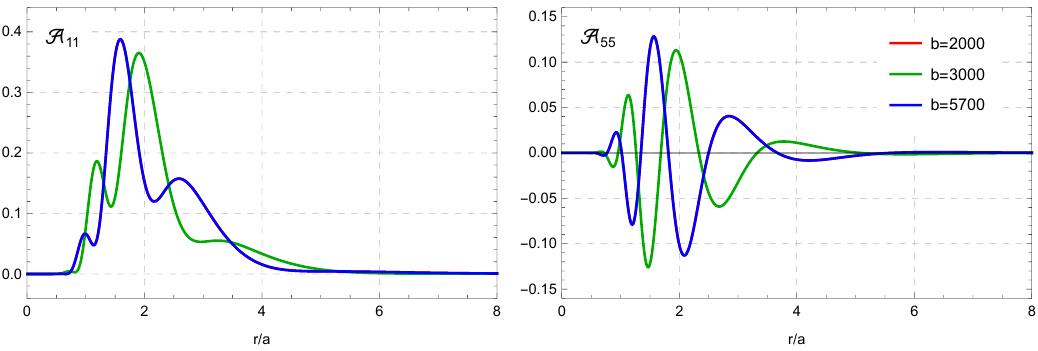
Figure 5 . Graphs of A 11 and A 55 for n = 9 and ˜ b = 2000 , 3000 and 5700. The curves are rescaled √ by ˜ b 2 ≡ ( b/ 2 a ) 2 and given in units of a 2 . For generic values of ˜ b the graphs differ, but for specific values of ˜ b , such as ˜ b 0 = 2000 and ˜ b 1 = 5700 , the plots are identical — in the above plots, the two curves are actually